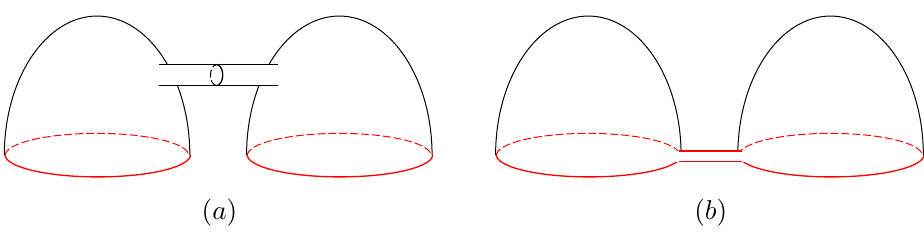
( a ) ( b ) Figure 10 . ( a ) The classical string con(cid:12)guration for the connected part of hW A of two disconnected surfaces joined together by an in(cid:12)nitesimal tube. ( b ) The classical string con(cid:12)guration for the (cid:12)gure eight loop. In this case, two disconnected surfaces are connected by an in(cid:12)nitesimal strip. This explains the di(cid:11)erence of the prefactors in (3.51) and